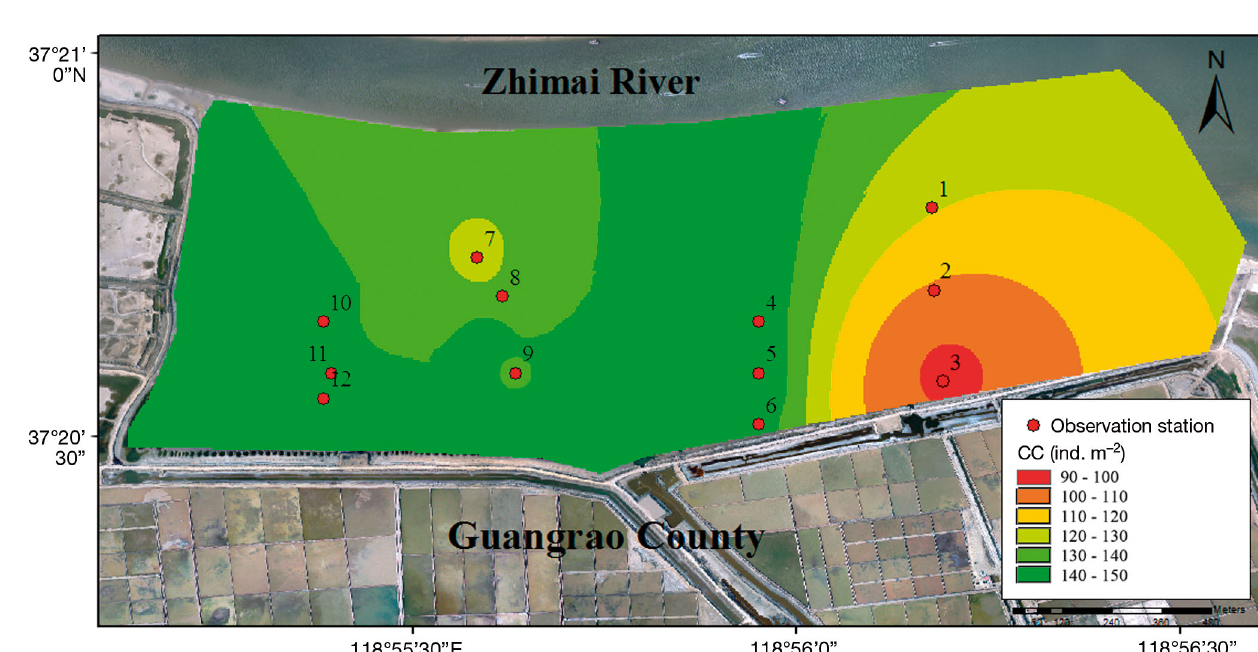
Fig. 5. Carrying capacity (CC) map for Perinereis aibuhitensis carrying capacity in the estuarine wetlands of the Zhimai